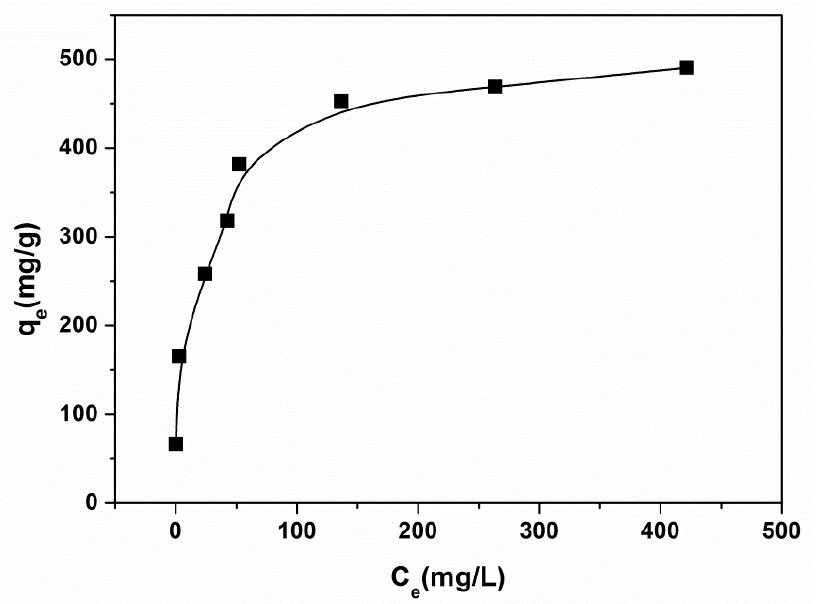
Figure 5. Adsorption isotherms of CR onto magnetic PGMA-g-PPy at room temperature. (Adsorbent dose, 28.5 mg; volume, 10 mL; pH, 2.0; contact time, 2 h.) The linear form of the Langmuir equation is represented as follows [37]: